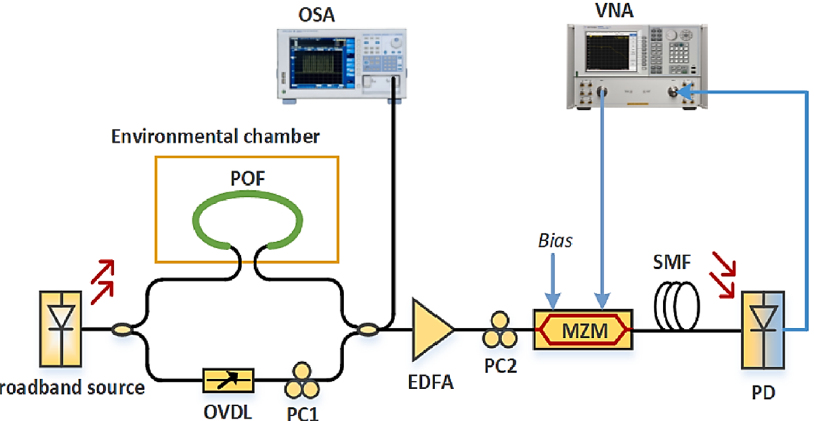
Figure 38. Point sensor. Experiment setup of the humidity sensor. (POF: polymer optical fiber; OVDL: optical variable delay line; PC: polarization controller; EDFA: erbium-doped fiber amplifier; MZM: